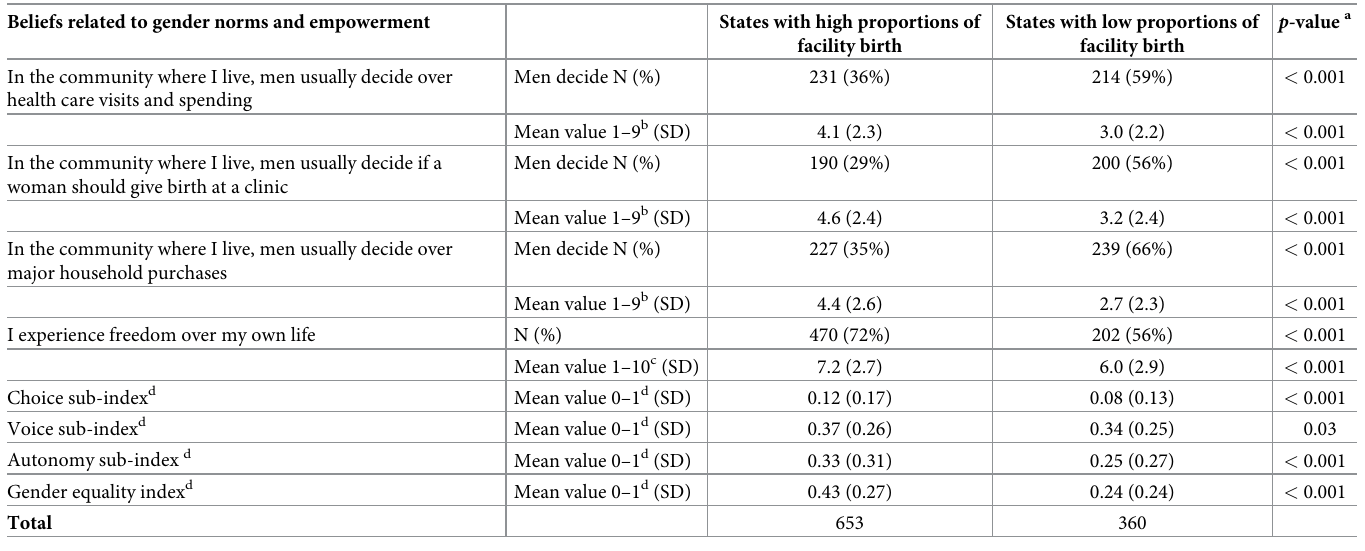
Table 4. Beliefs related to gender norms and empowerment in